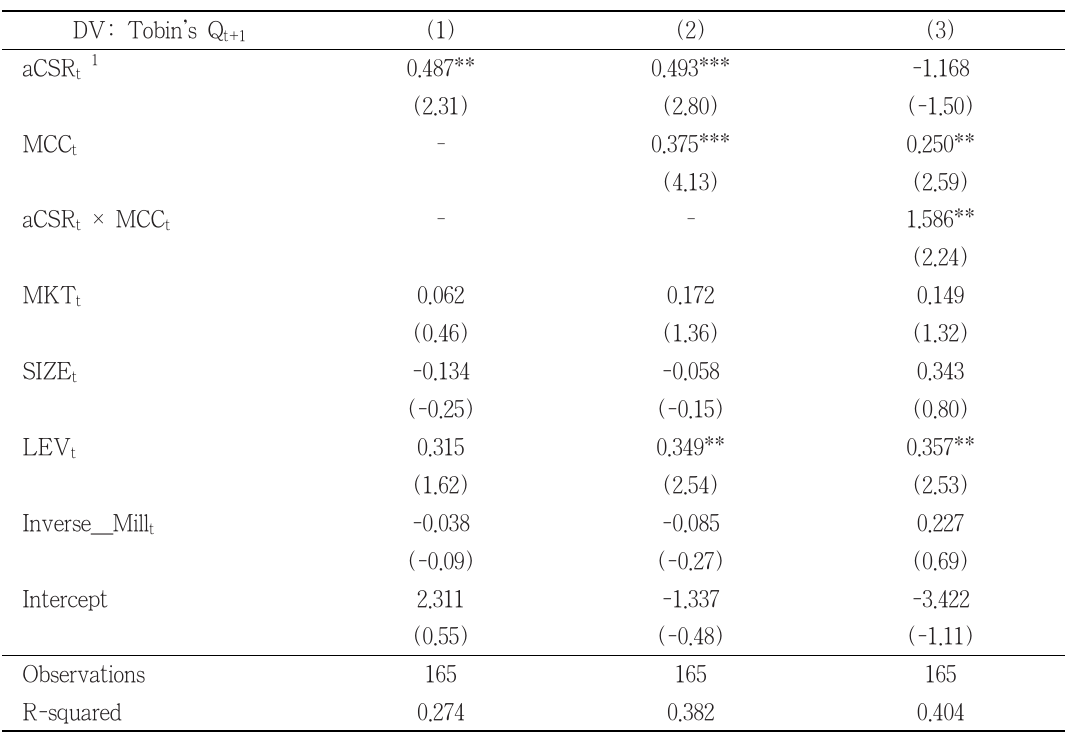
<Table 3> Robustness Tests: The Effects of CSR, MCC, and the interactions on Tobin’s Q (with alternative measure of